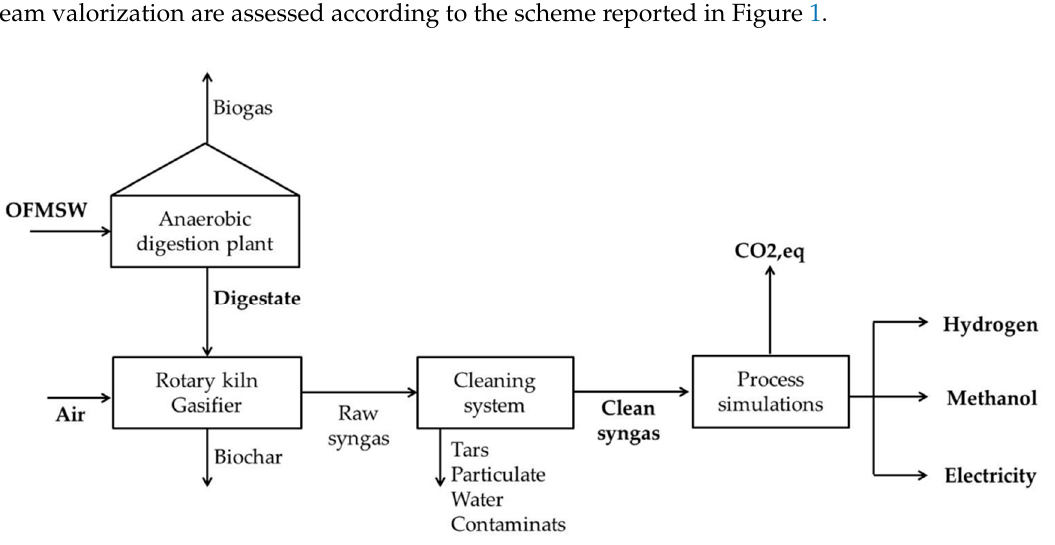
Figure 1. Scheme of the proposed integrated scheme for digestate valorization.